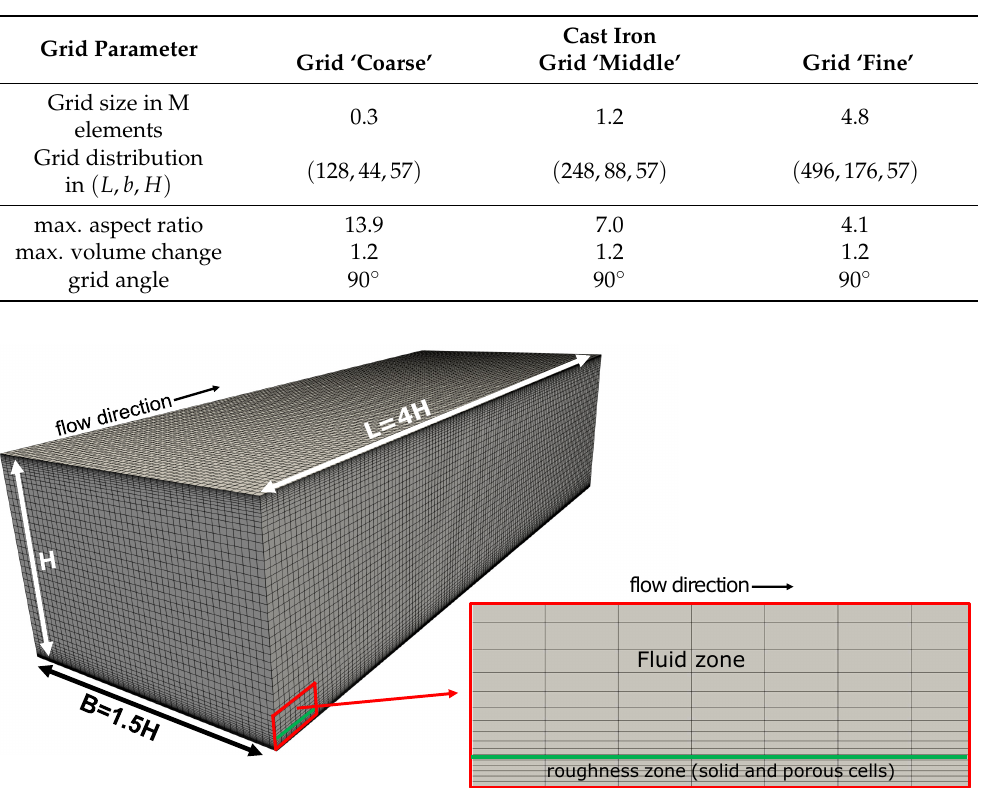
Table 3. Properties of the three computational grids for the simulation of the cast iron roughness.